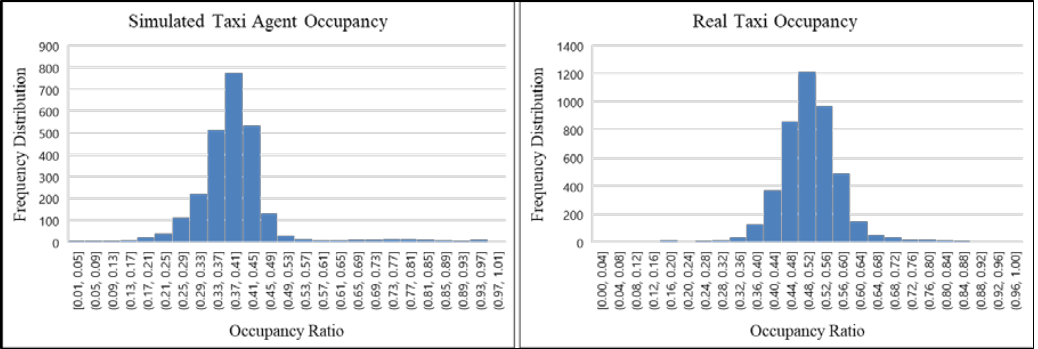
Figure 22. Taxi occupancy. Left : Simulated taxi agent data; Right : Real taxi data.